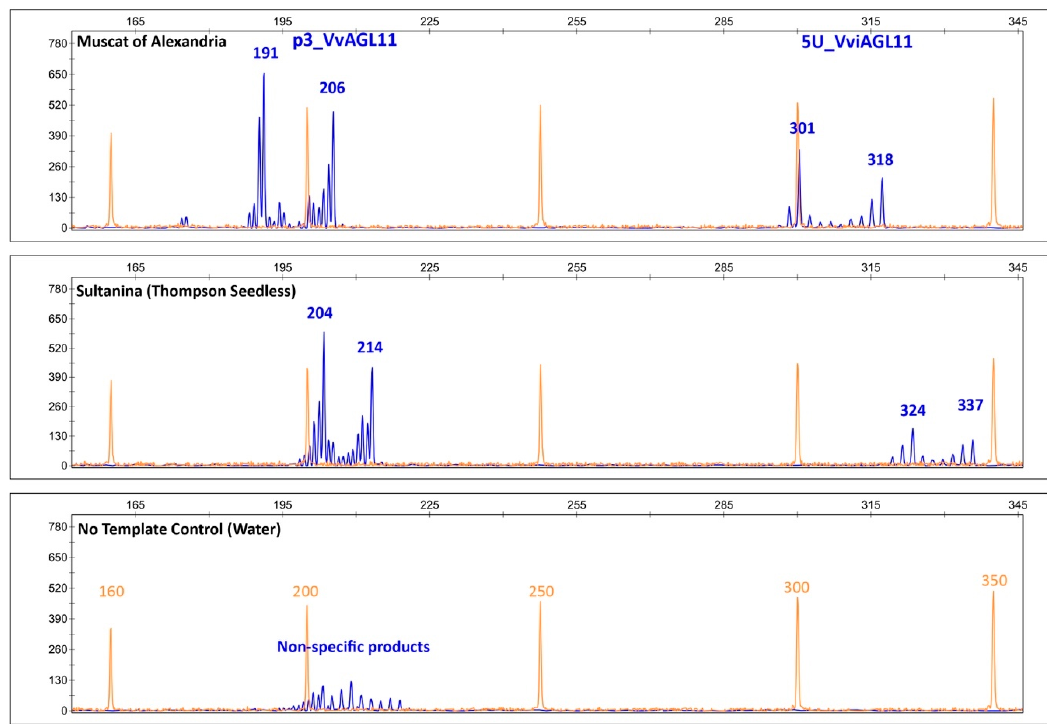
Figure 5. Capillary electrophoretic profile of SSRs p3_VvAGL11 and 5U_VviAGL11. Orange: the profile of the GeneScan 500 LIZ Size Standard (Applied Biosystems, Foster City, CA, USA). Blue: the specific profile of p3_VvAGL11 and 5U_VviAGL11 markers that amplify, respectively, 191 / 206 bp and 301 / 318 bp alleles in Muscat of Alexandria and 204 / 214 bp and 324 / 337 bp in Sultanina. No template control unspecific product amplified by p3_VvAGL11 is shown. Amplified products contain the M13 tail ( + 18 bp) labeled with FAM fluorescent dye.